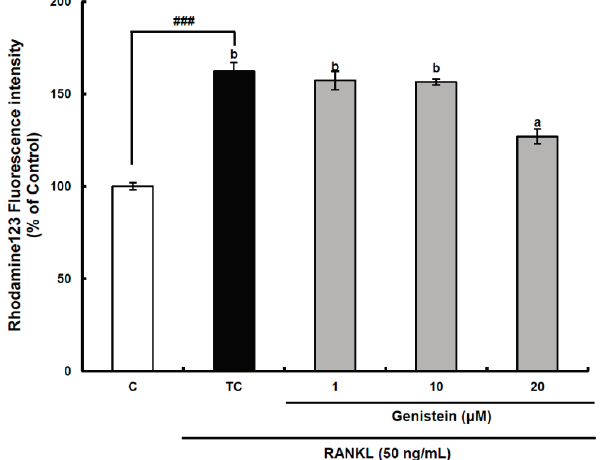
Figure 5. The effect of genistein on mitochondrial membrane potential in RANKL-treated Raw264.7 cells. RAW 264.7 cells were exposed to the receptor activator of nuclear factor kappa-B ligand (RANKL) (50 ng/mL) for two days in the absence and the presence of genistein. After two days of incubation, the wells were gently washed twice with PBS. HBSS, which is fluorescently stable, was then added to each well. Rhodamine 123, a fluorescent probe detecting mitochondrial membrane potential, was added to the culture plates at a final concentration of 5 µM and incubated for 30 min at 37 °C in the dark. After the cells were washed with HBSS, the fluorescence intensity of rhodamine 123 was measured with an excitation wavelength of 485 nm and an emission wavelength of 535 nm using a Tecan GENios fluorometric plate reader. Data are expressed as percentages of the values of untreated cells (means ± standard deviations, n = 3). Different corresponding letters indicate significant differences at p < 0.05 by Duncan’s test. ### p < 0.001 vs. C (C: control, which was not treated; TC: treated control, which was treated with